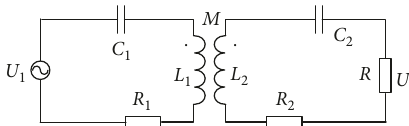
Figure 5: Circuit model of wireless power transmission